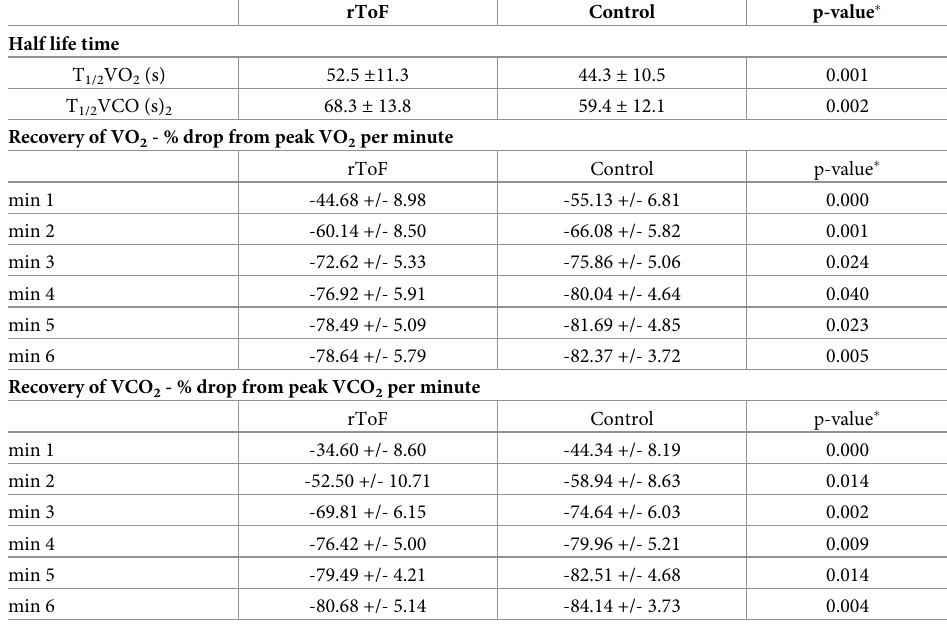
� : statistically significant difference p < 0.05; Values are expressed as mean ±